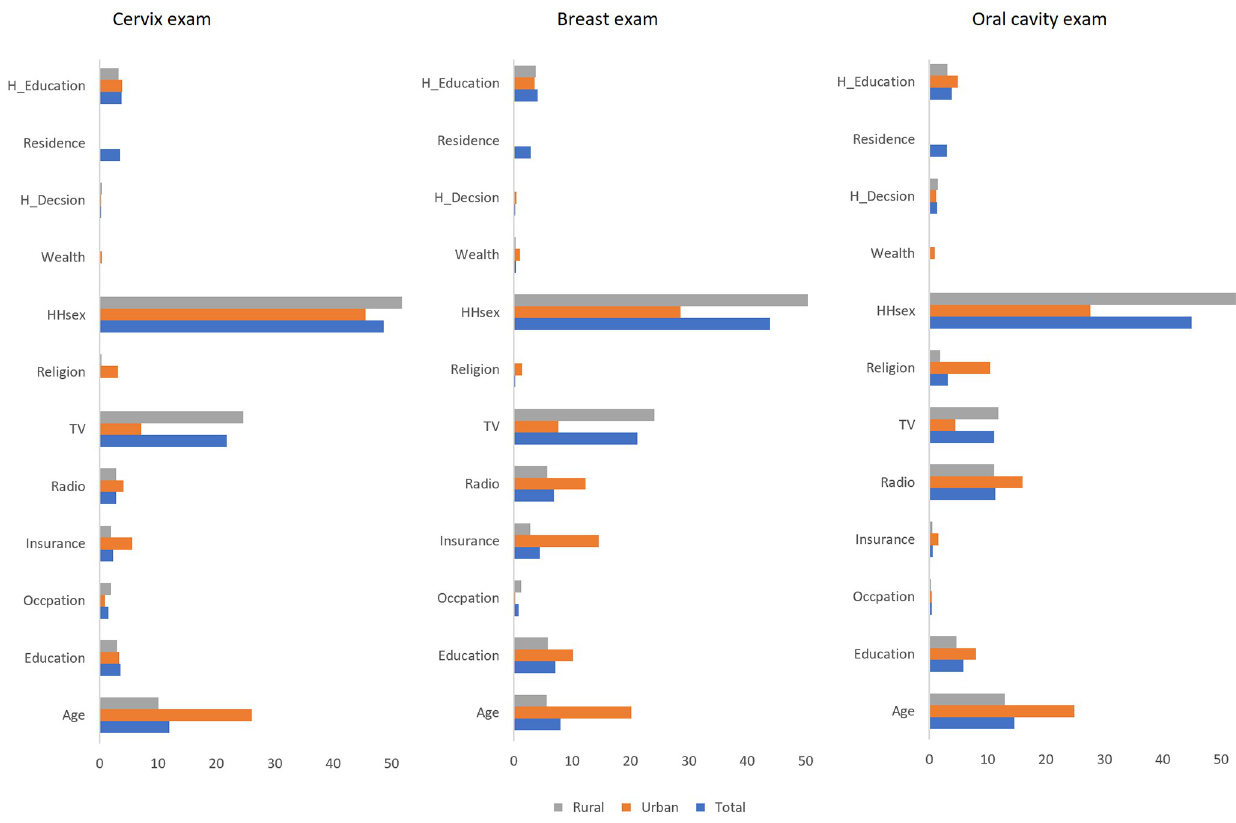
Fig 4. Percent contribution of the explanatory variables to the